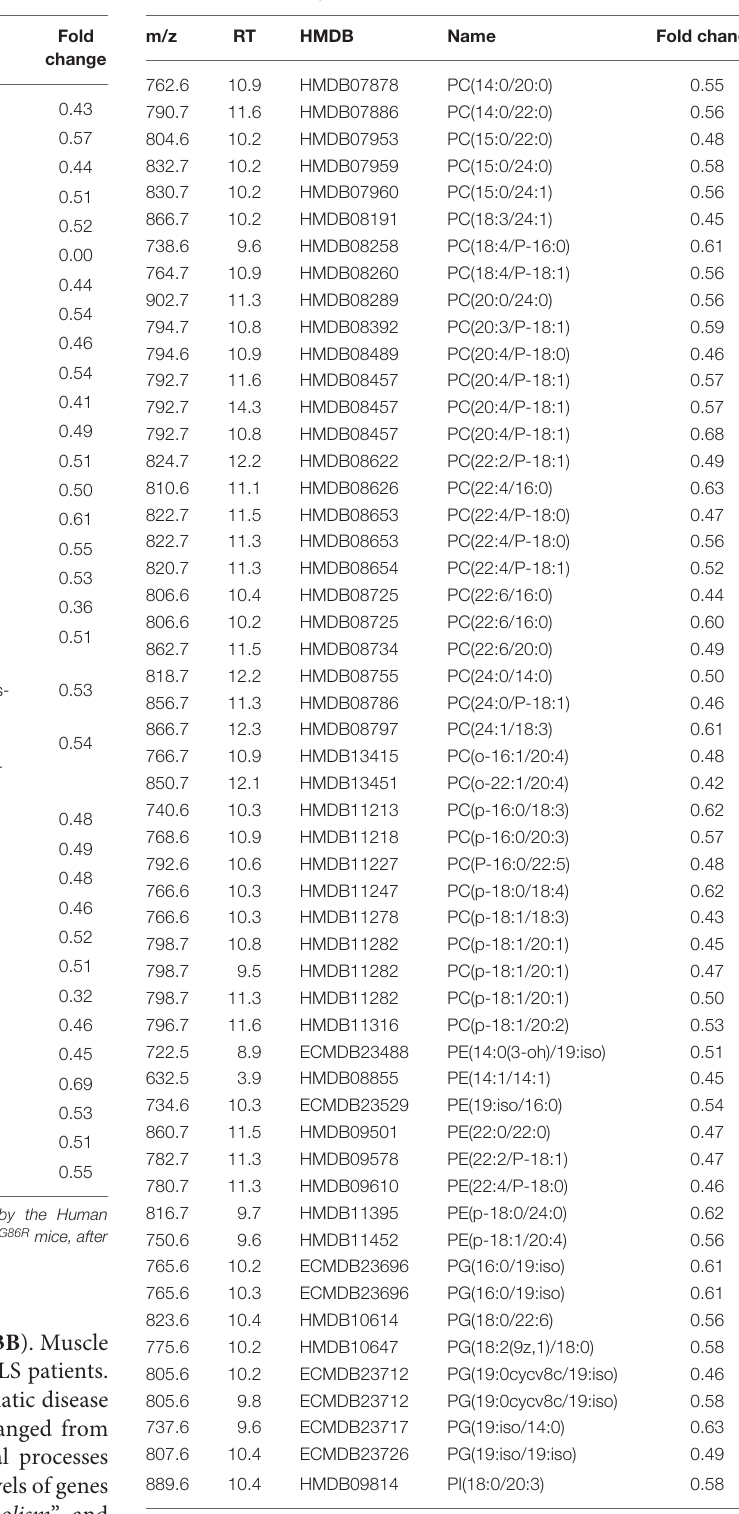
TABLE 3 | Dysregulation of phospholipids metabolites in the spinal cord of SOD1 G86R mice, after positive ionization , and tentative